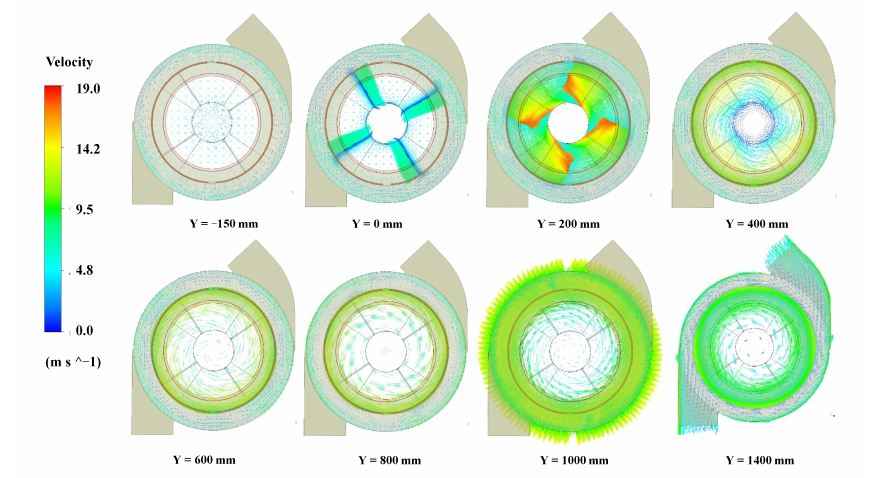
Figure 9. Velocity vector contours from Y = − 150 mm to Y = 1400 mm in the reference